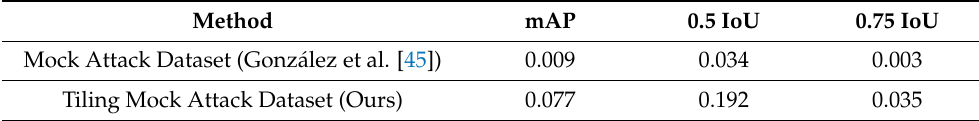
Table 11. The object detection evaluation on the mock attack